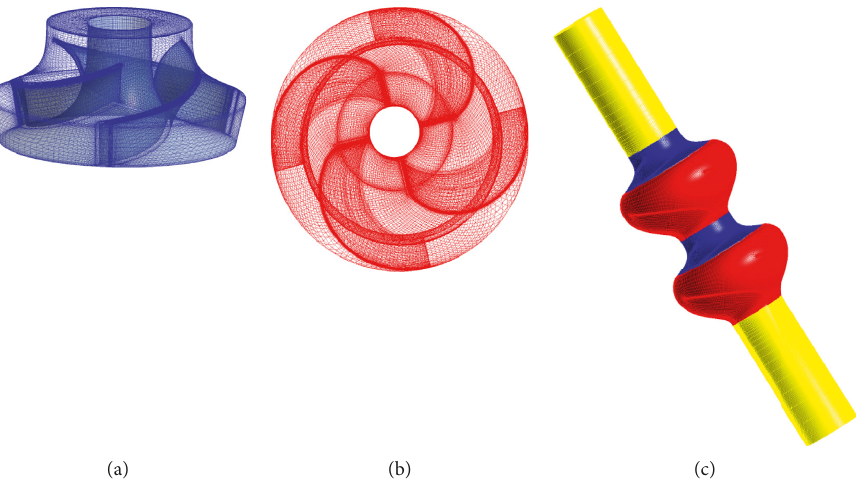
Figure 4: Computational grids used for the electric lifting pump: (a) impeller, (b) diffuser, and (c) two-stage model.